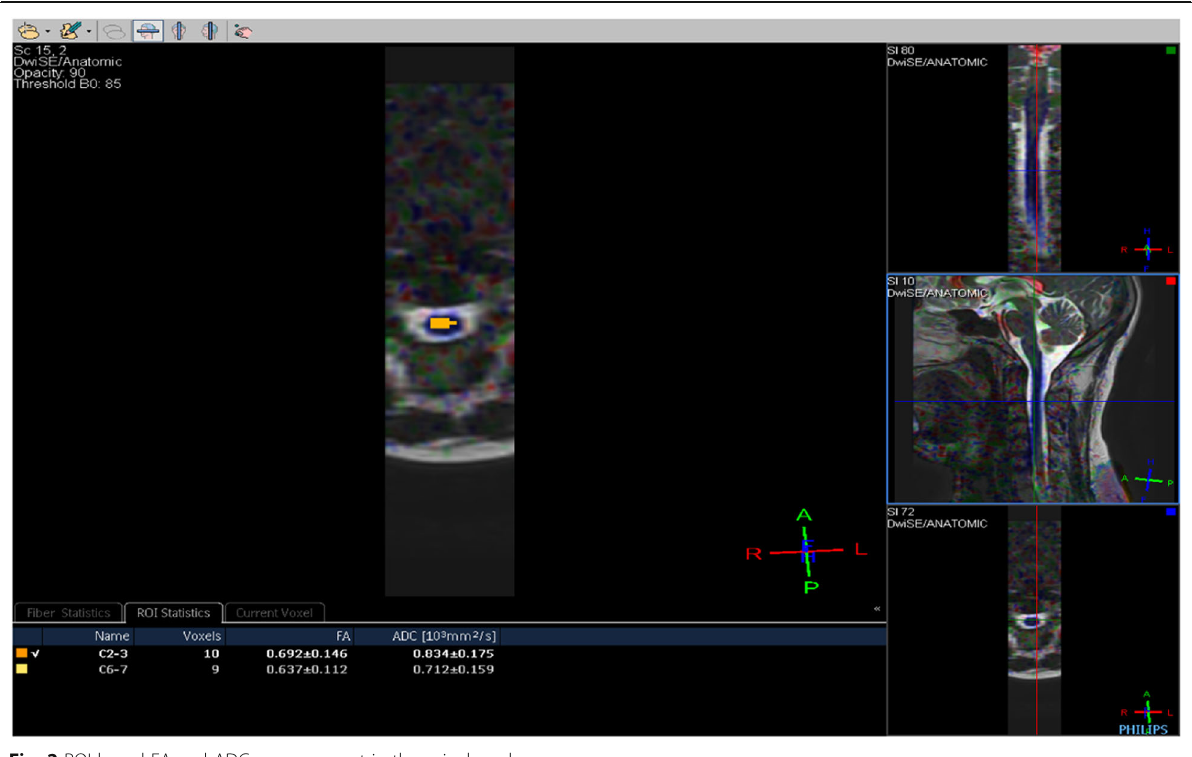
Fig. 2 ROI-based FA and ADC measurement in the spinal cord